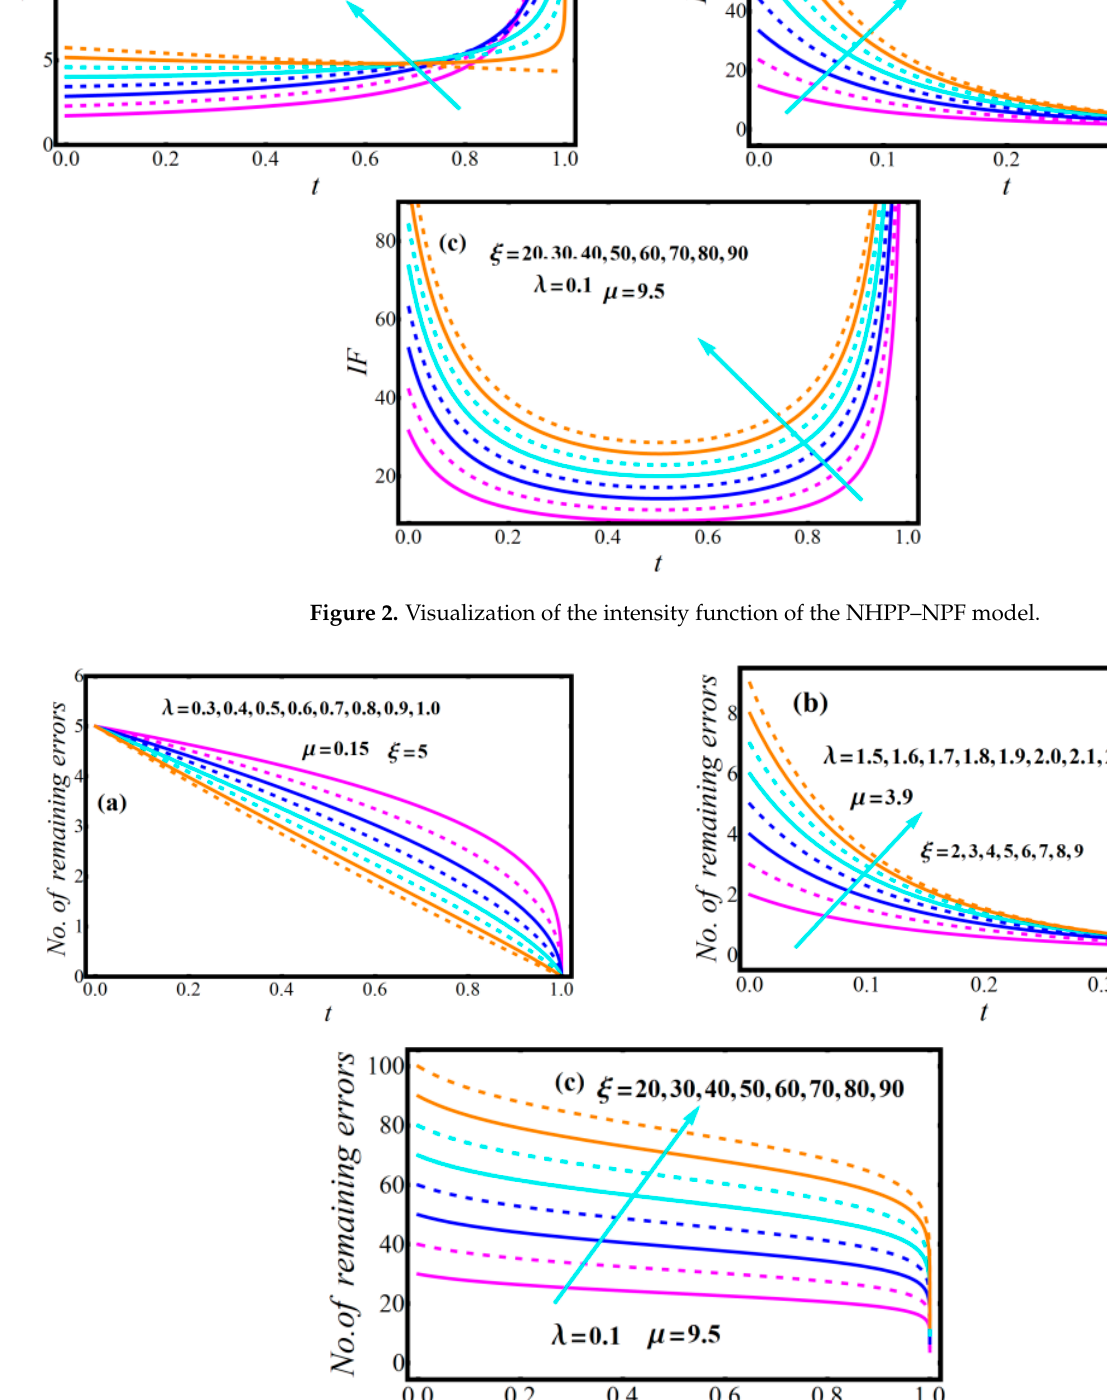
Figure 3. Plots of the number of remaining faults’ function of the NHPP–NPF model.